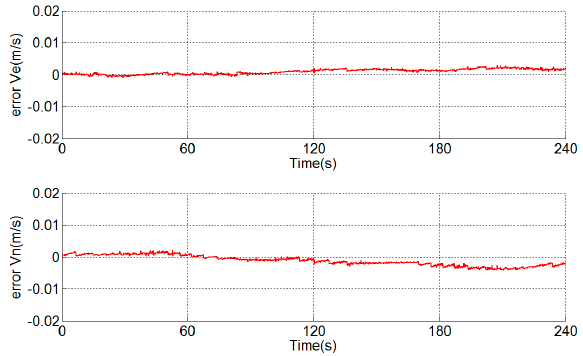
Figure 7. Velocity errors.